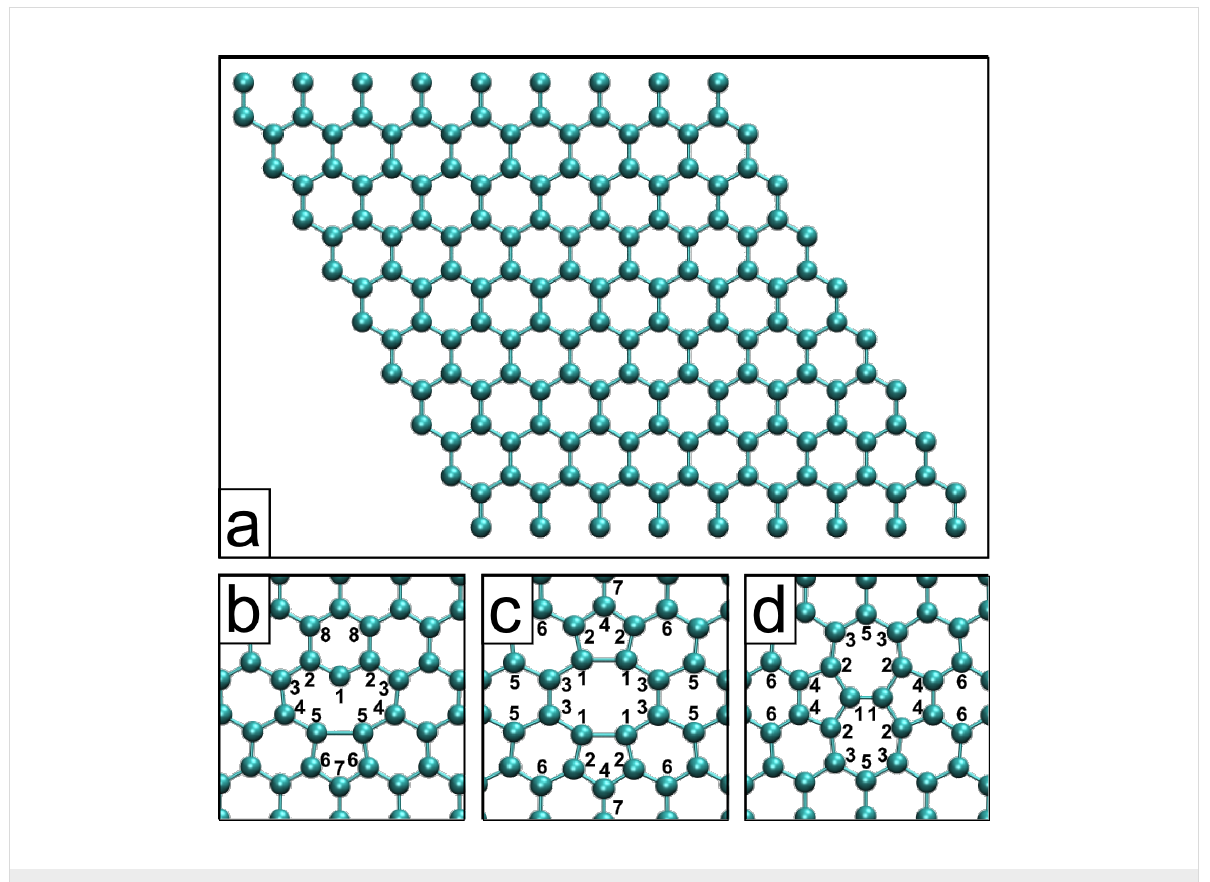
Figure 1: a) The 9 × 9 graphene computational unit cell. Cropped relaxed structures of the b) reconstructed single vacancy (SV), c) the double vacancy (DV), and d) the Stone–Thrower–Wales (STW)